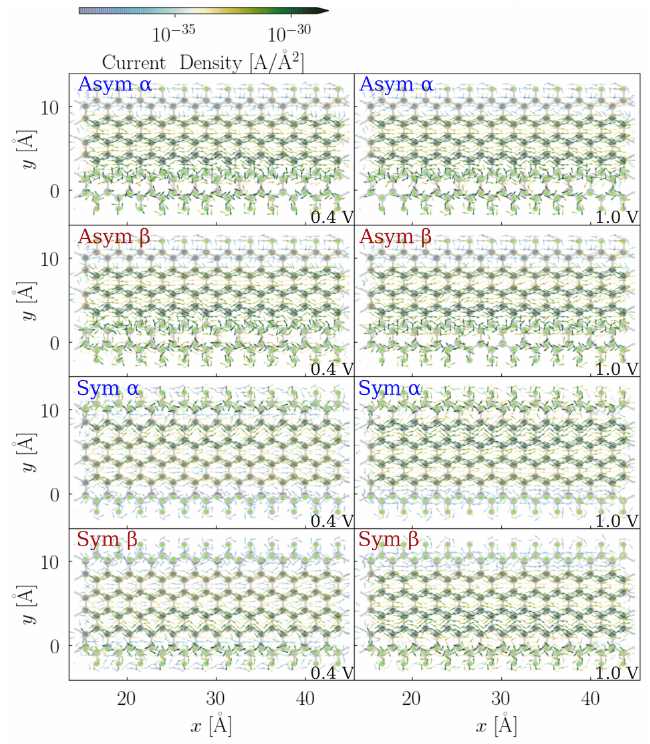
Figure 10. Quiver plot of the electronic current density projected on the real space of the scattering regions of both asymmetric and symmetric 33.33% fluorinated F-6Z. The grid spacing is chosen as 1 atomic unit in the volume of the cell cartesian coordinates. The bias voltage along the x -axis of the nanojunction plane is applied. The upper two panels illustrate the α and β spin channels of asymmetric 33.33% fluorinated F-6Z (originated from 2(A), both at 0.4 V and 1 V bias voltages, respectively, whereas the lower two panels denote the α and β spin channels of symmetric 33.33%